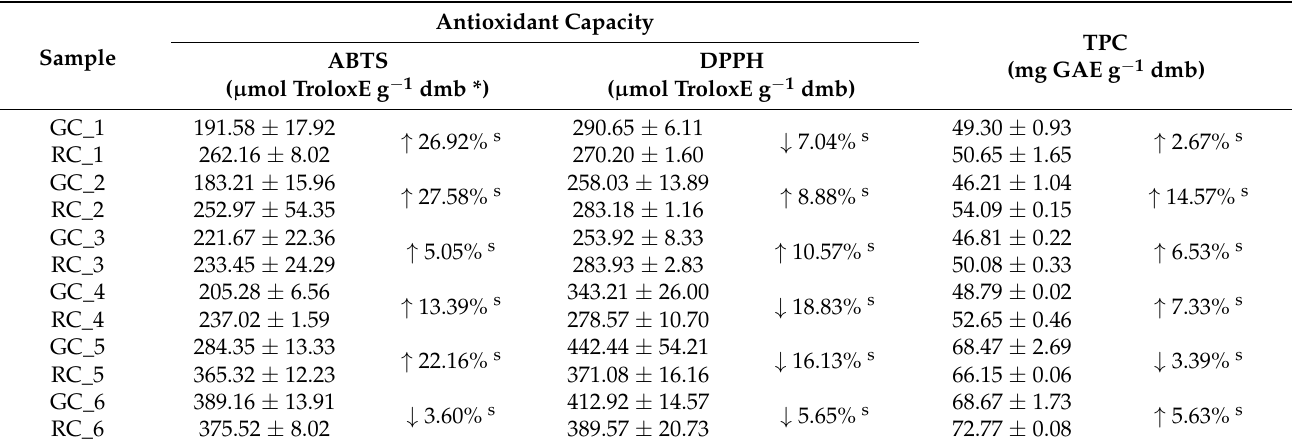
Table 4. Antioxidant capacity and total phenolic content (TPC) of green (GC) and roasted (RC) coffee